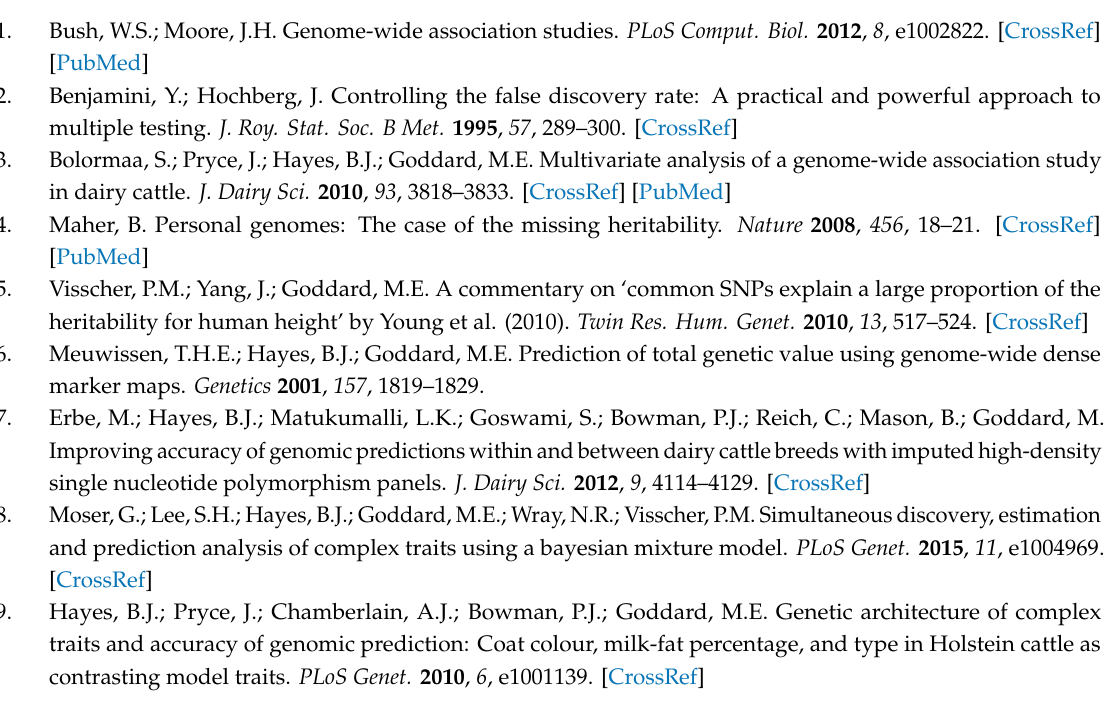
Table S1: List of the 76 most associated markers to the respective trait that had genes in their boundaries. Author Contributions: E.M. and C.D. conceived the idea and formulated the objectives of this study; C.D., G.G. and N.P.M. supervised the project and wrote the first draft of the paper.; E.M. and A.C. prepared and analyzed data; S.S. conducted the gene discovery. All authors contributed to discussions and critically contributed to the final version of the manuscript. All authors have read and agreed to the published version of the manuscript. Funding: This research was funded by fondo di Ateneo per la ricerca, Dimauro 2019, University of Sassari. Conflicts of Interest: The authors declare no conflict of